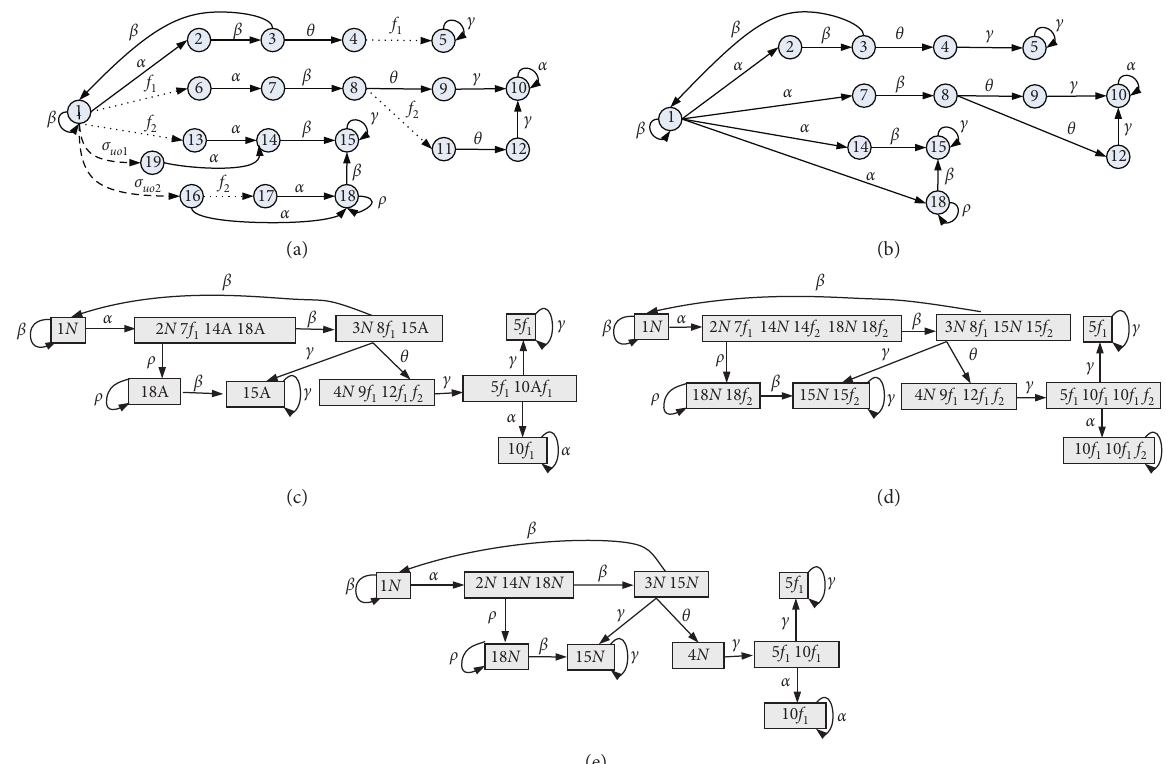
Figure 1: A DES and its related variant diagnosers: (a) DES model G . (b) Nondeterministic FSM G o for G . (c) Classical diagnoser G